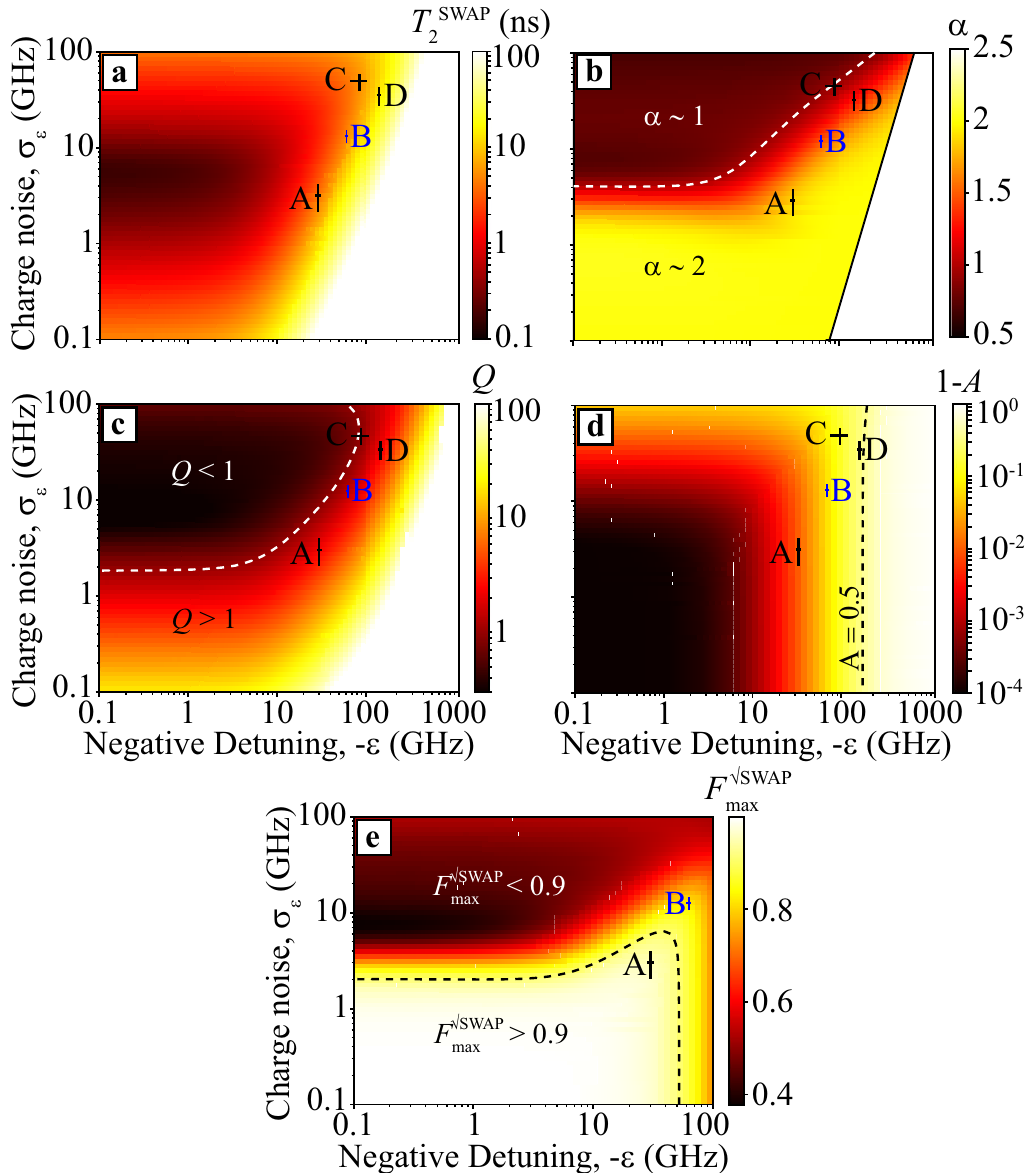
Fig. 3 Quantifying the impact of charge noise on exchange oscillations. Using the Hubbard model for the detuning dependence of J we Þ α Þ , c quality factor Q , extract the a decoherence time T SWAP , b α from the decay pro fi le of the oscillation envelope function exp ð(cid:2)ð t w = T SWAP ffiffiffiffiffiffiffiffiffiffiffiffiffi p 2 2 ffiffiffiffiffiffiffiffiffiffiffiffiffiffi p SWAP d initial amplitude A of exchange oscillations, and e maximum fi delity of a SWAP gate F as a function of the charge noise standard max deviation σ ϵ and detuning position ϵ relative to the anti-crossing calculated using t c = 4.3 GHz to match 7 . The error bars (A – D) in b represent the corresponding data points from experimental exchange oscillations 7 whose oscillations and parameters are displayed in Fig. 4 and Table 1 respectively. The blue error bars (B) in each fi gure corresponds to experimental parameters used to achieve coherent exchange oscillations by 7 . The dotted white line in b depicts the contour where σ ϵ = J (which causes α to transition from 1 to 2) forming a boundary between regions of exponential and Gaussian decay. The lower right values (white) in b are left out due to practical time resolution limitations of the calculations. The darker values inside the white dotted line in c achieved quality factors Q < 1, whilst the values to the left of the black dotted line in d achieved initial oscillation amplitudes A > 0.5. The brighter values in e below the black dotted line shows where σ ϵ is low enough to ffiffiffiffiffiffiffiffiffiffiffiffiffi p SWAP > 0 : 9 achieve a maximal fi delity F max